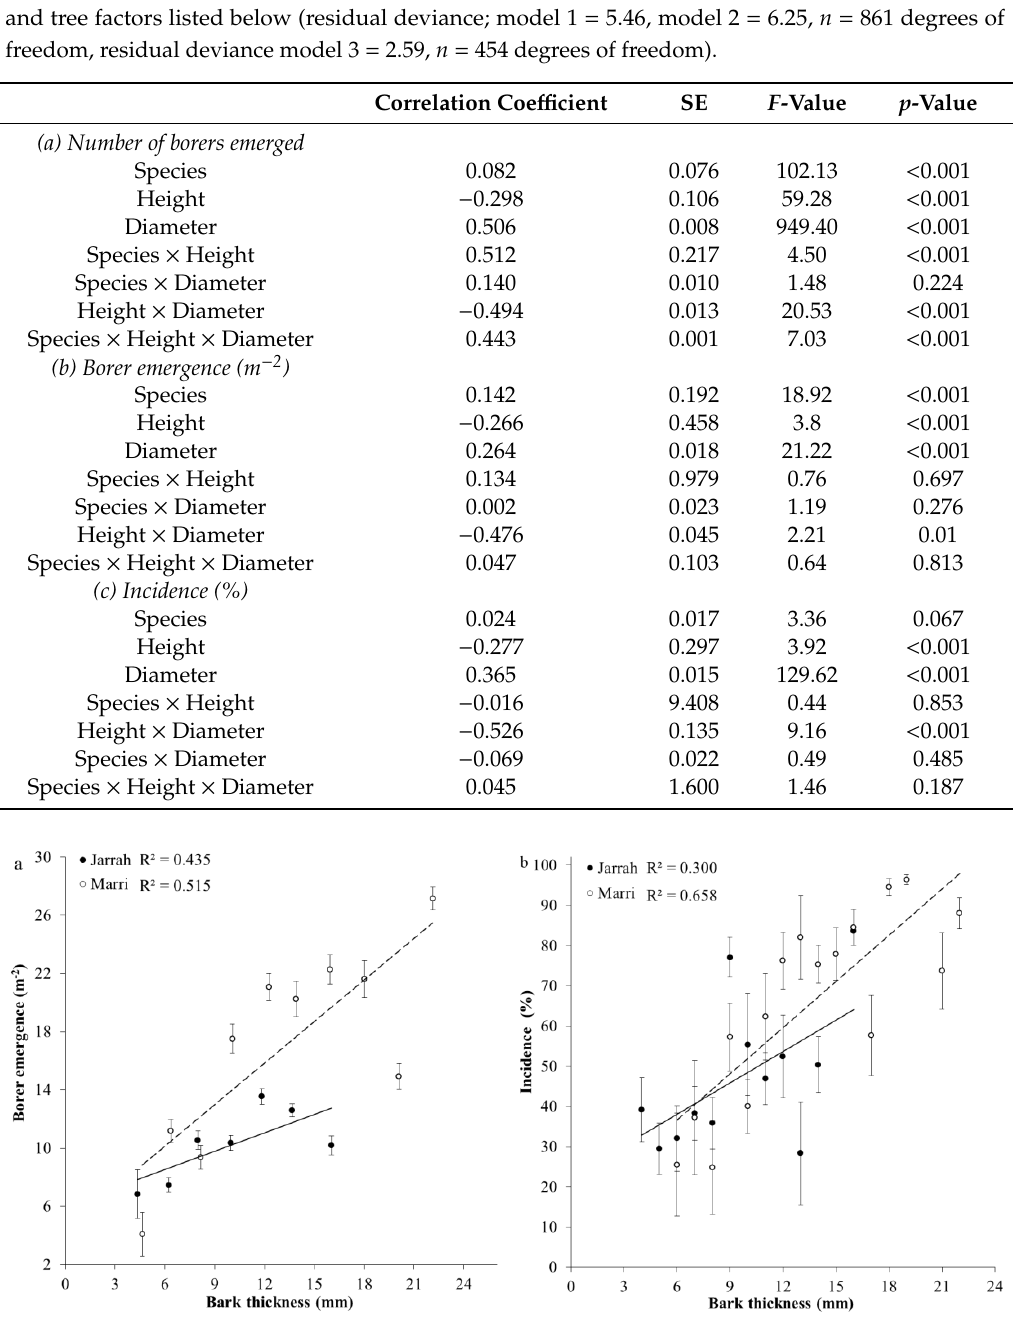
) ( n = 39) trees (cid:35)